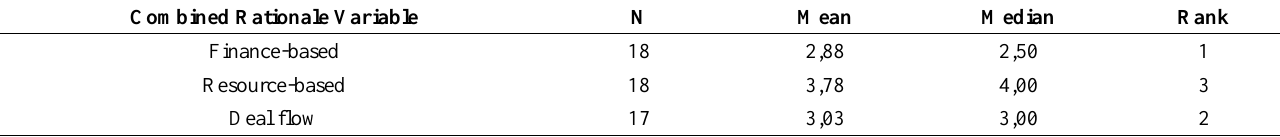
Table 1: Measures of central location for the three aggregate rationale variables